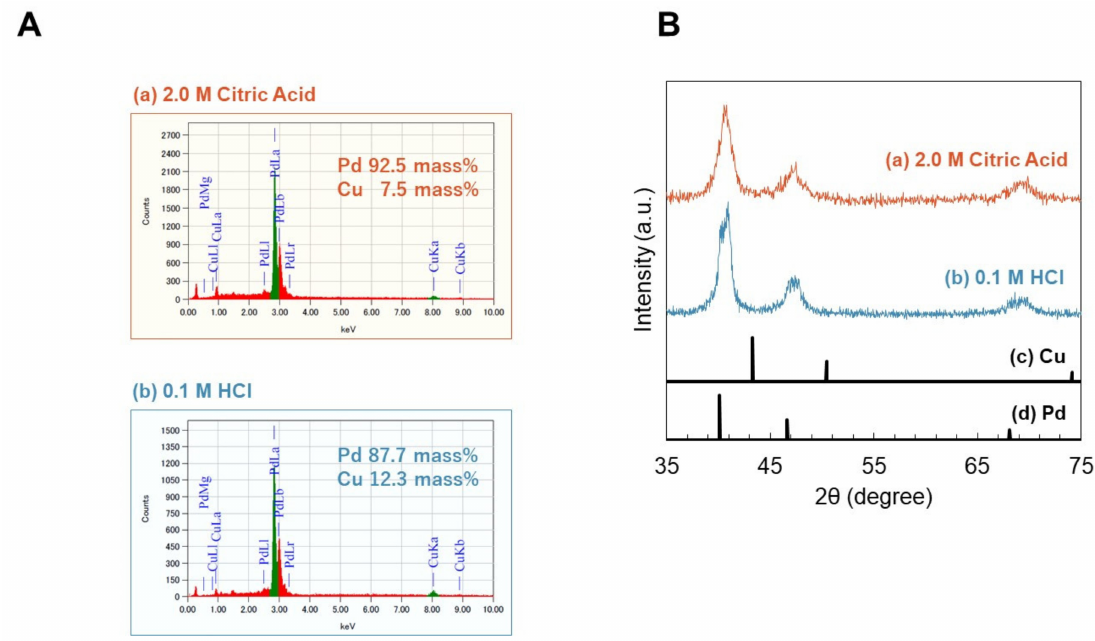
Figure 4. Characterization of 3D nanostructure. ( A ) The weight composition ratio of the precipitates obtained by the addition of citric acid aqueous and HCl aqueous. The composition of the precipitates were determined by Energy Dispersive X-ray Spectrometry (EDS) analysis, and only Cu and Pd were detected. ( B ) Di ff raction patterns of precipitates obtained by addition of 2.0 M citric acid aqueous and 0.1 M HCl